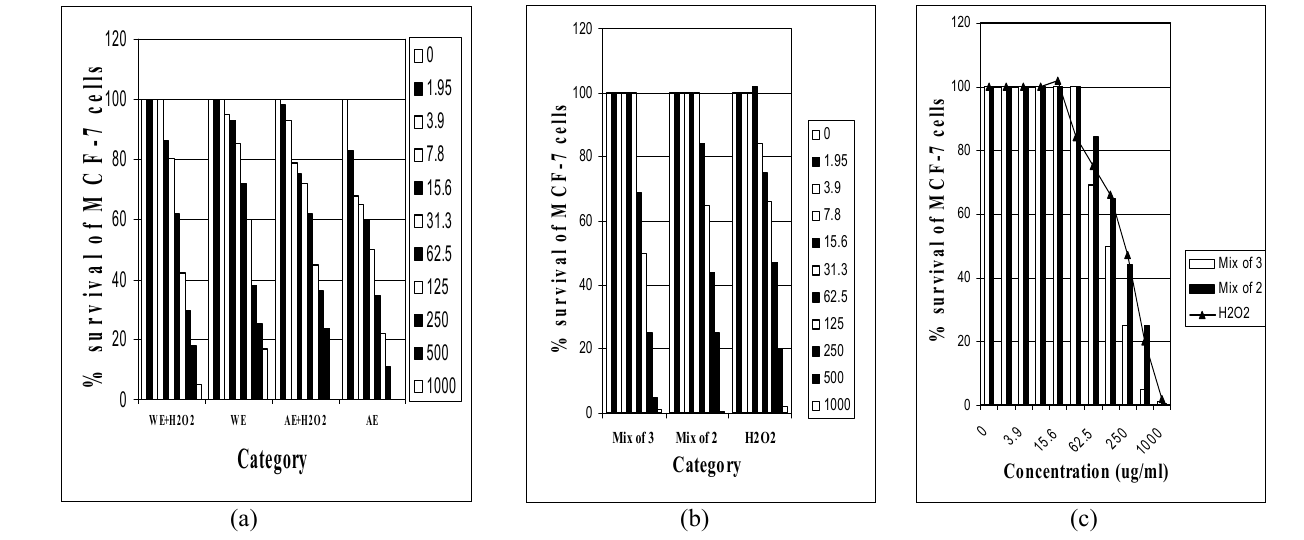
Figure 3 : Cellular response of MCF-7 breast cancer cell line to a 48 hour exposure to (a) water, alcohol extract of black seed alone or in combination with H water and alcohol extract of black seed and H complete RPMI medium and the FDA